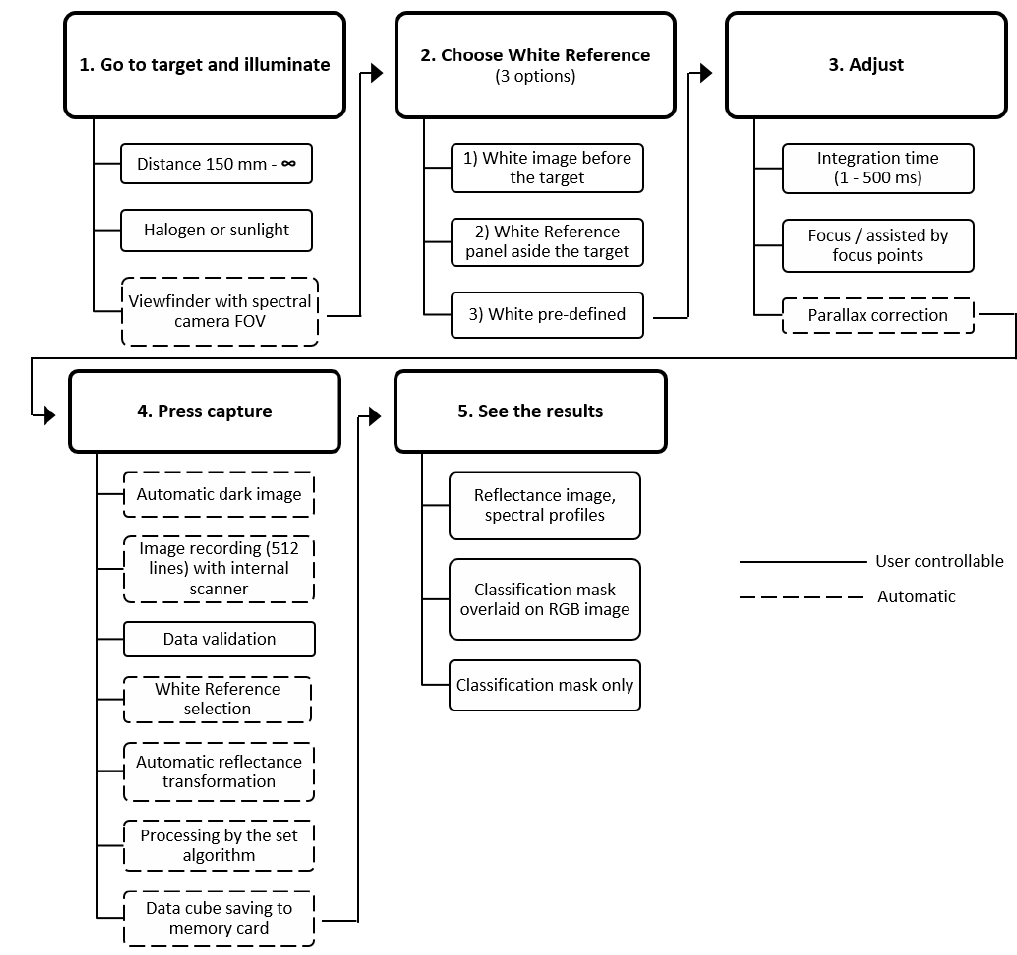
Figure 2. The standard workflow of the Specim IQ hyperspectral